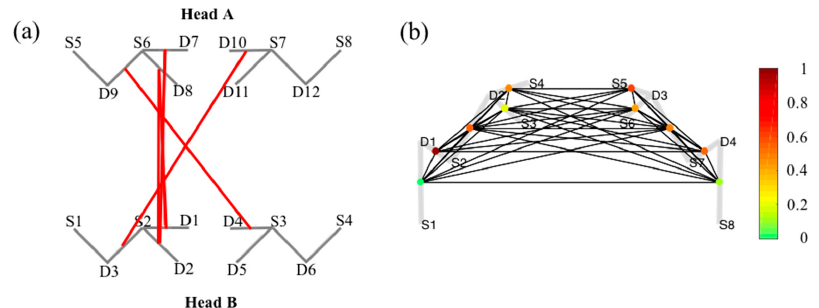
Figure 5. Examples of connectivity analyses employed by AnalyzIR: ( a ) Connectivity between two subjects during cooperation on a puzzle task; ( b ) relative PageRank centrality for a single